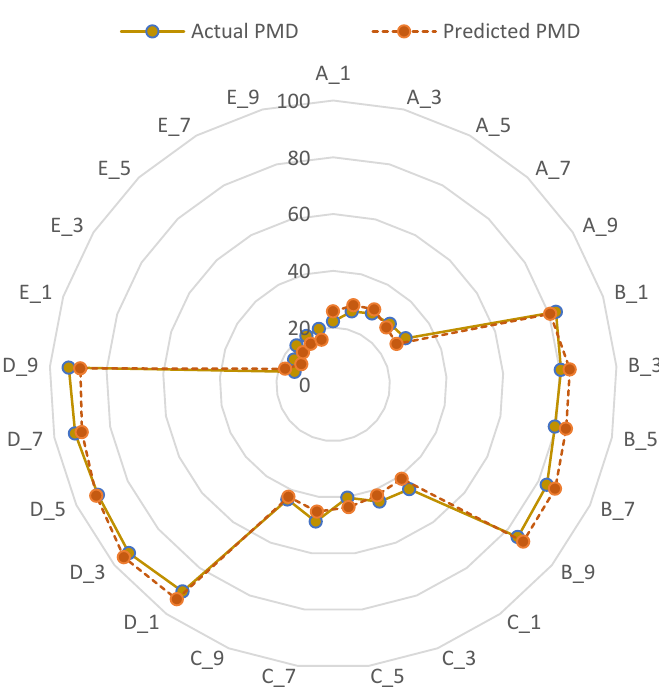
Figure 10. Demonstration of the actual and predicted PMD values of chernozem soil on tests A_1 to E_10, implemented on layers A – E, respectively.